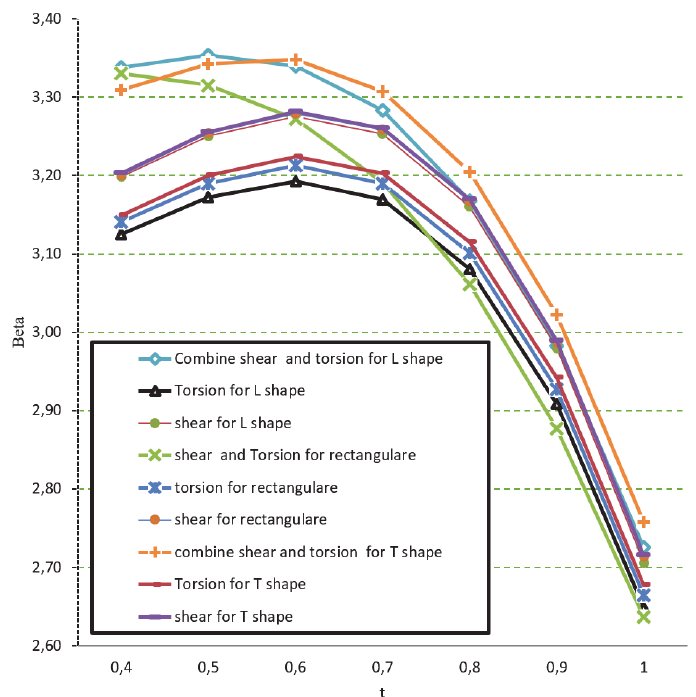
Figure 4: ACI beta index for shear-torsion